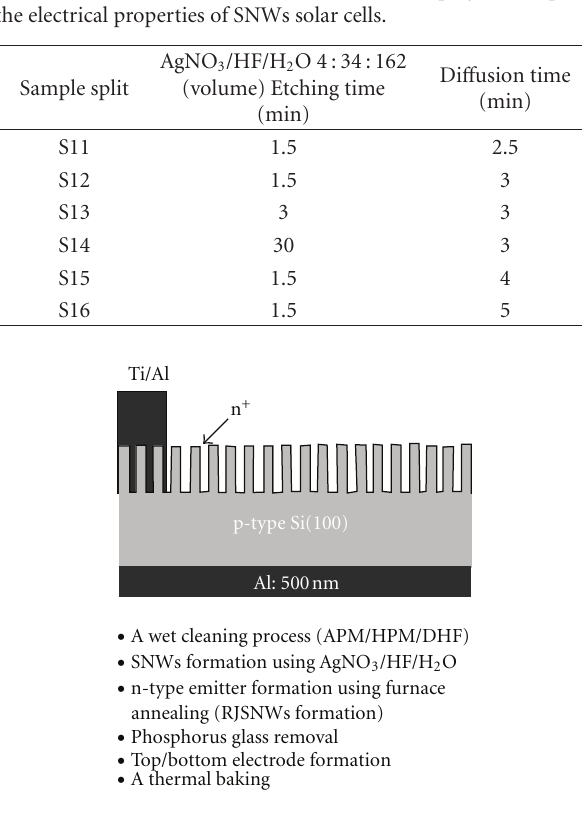
Figure 1: Schematic structure of radial junction silicon nanowire (RJSNW) solar